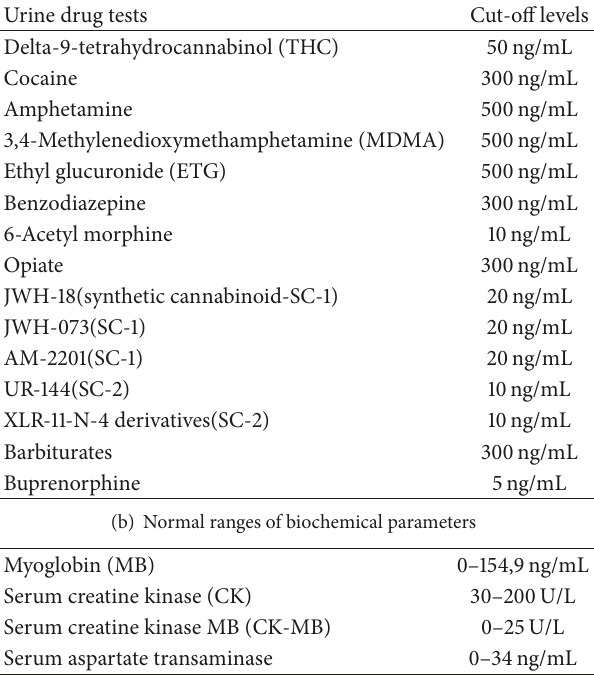
(a) Urine drug tests and cut-off